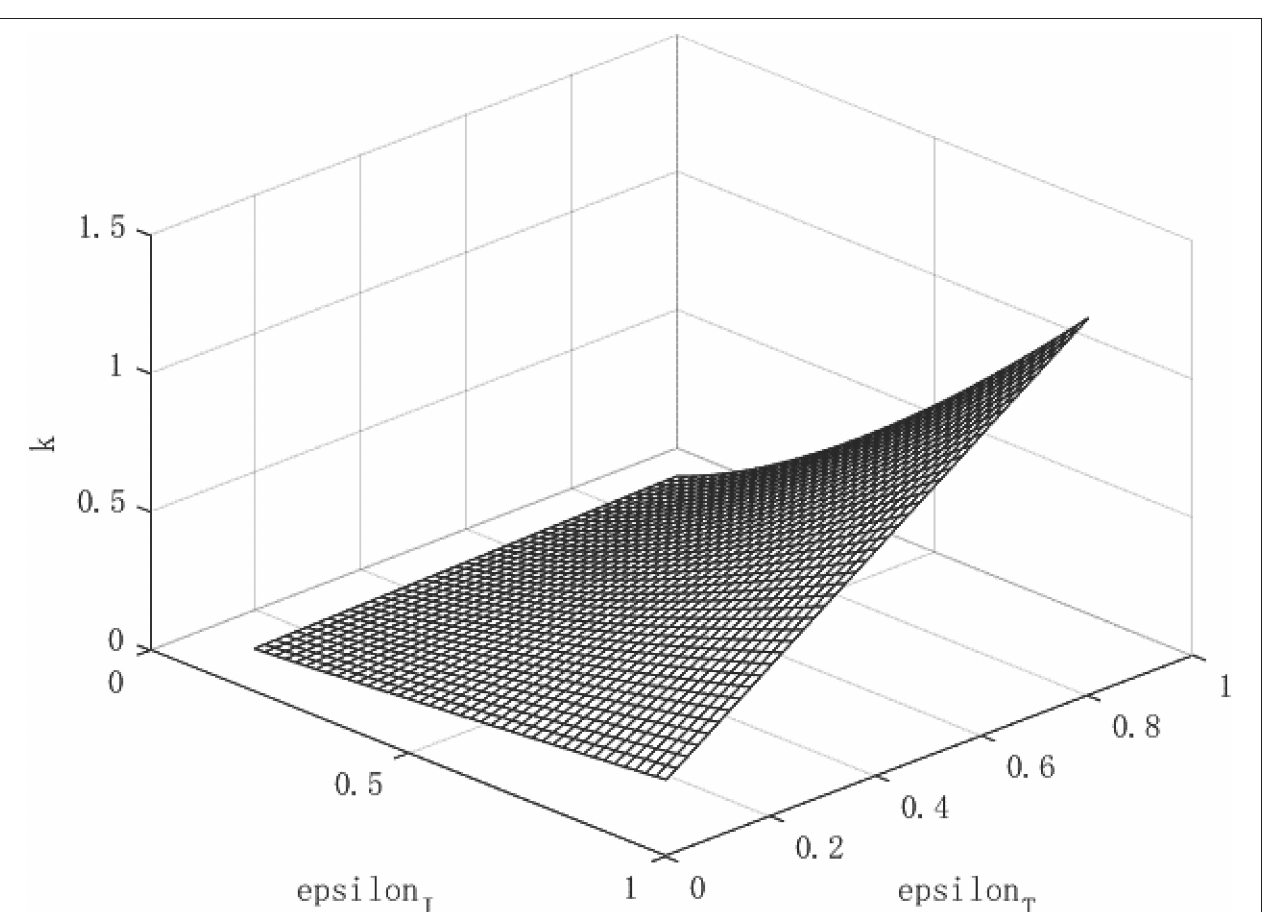
FIGURE 5 | Growth path of per capita capital under low contagious public health